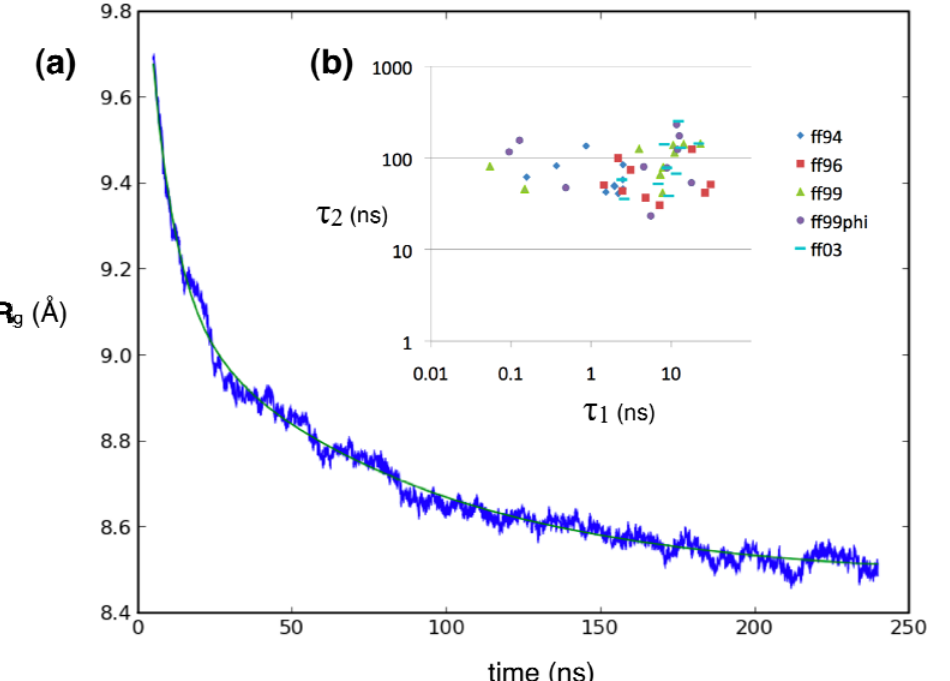
Figure 4. Simulated relaxation kinetics for D P D P-II, as characterized by the average radius of gyration. (a) An example trace of the average radius of gyration over time (blue) with the best-fit bi-exponential curve (green). (b) Fitted bi-exponential time constants  across all forcefields and starting